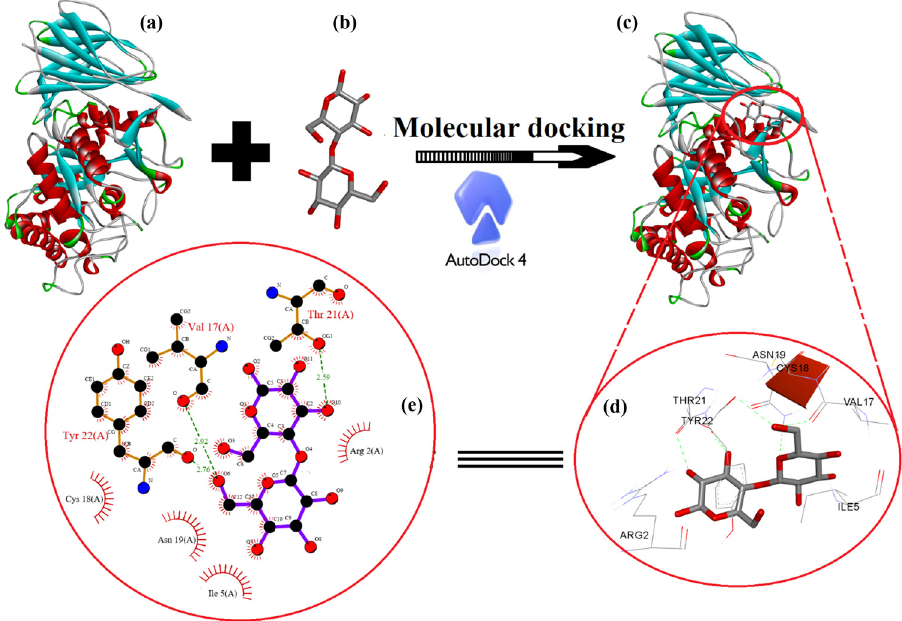
Figure 10: Molecular docking analysis between ( a ) human acid - beta - glucosidase ( PDB: 1OGS ) ( b ) cellulose unit ( c ) , including the best - docked pose showing various interactions pro fi les and ( d and e ) 2D interaction diagram showing the active site participation in hydrogen such as hydrophobic and hydrophilic